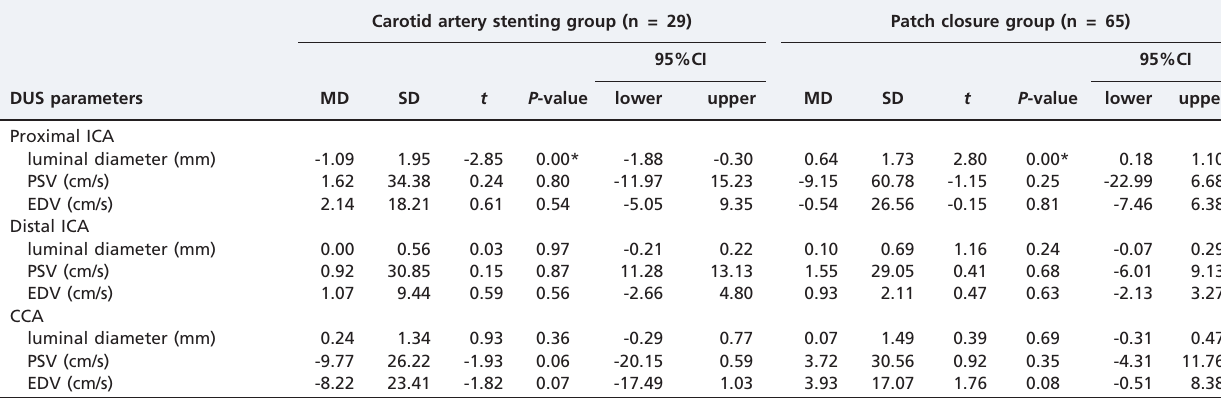
Table 3 – DUS results: Comparison of postoperative day 1 and 12 months.